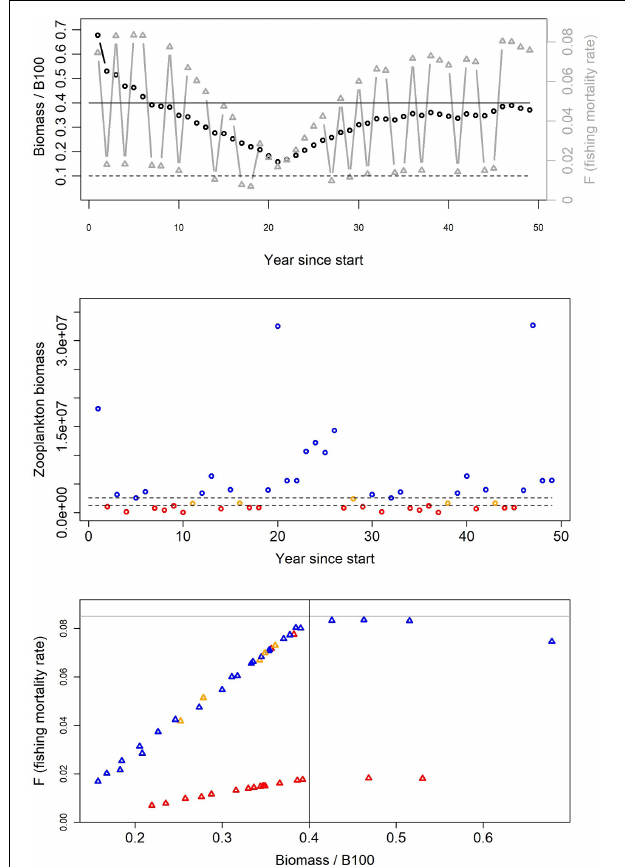
FIGURE 4 | Example time series of Pacific hake biomass and F (top panel) , zooplankton biomass (middle panel) , and F versus biomass (bottom panel) from the California Current Atlantis model. These are outputs from a threshold harvest rule for target fish that scales fishing in step with productivity (if zooplankton falls below < 25%; Table 1 , Rule 4). More specifically, for this US example, F rates from the 40/10 hake threshold rule are decreased by 79% if euphausiid abundance falls below 25% of baseline euphausiid abundance. Note the high variability in F for this harvest rule ( top panel , gray symbols linked by gray lines). In the top panel the solid black line indicates the B TARGET reference point below which the fishing mortality rate is reduced (B40), and the dashed black line indicates the B LIM reference point below which harvest is stopped (B10). In the middle panel , points indicate whether zooplankton abundance is below 25% (red), between 25 and 50% (orange), or above 50% (blue). In the bottom panel , the solid gray horizontal line indicates the maximum fishing mortality rate (F MSY ), the solid black line indicates the B TARGET reference point, and points are colored identically to the middle panel